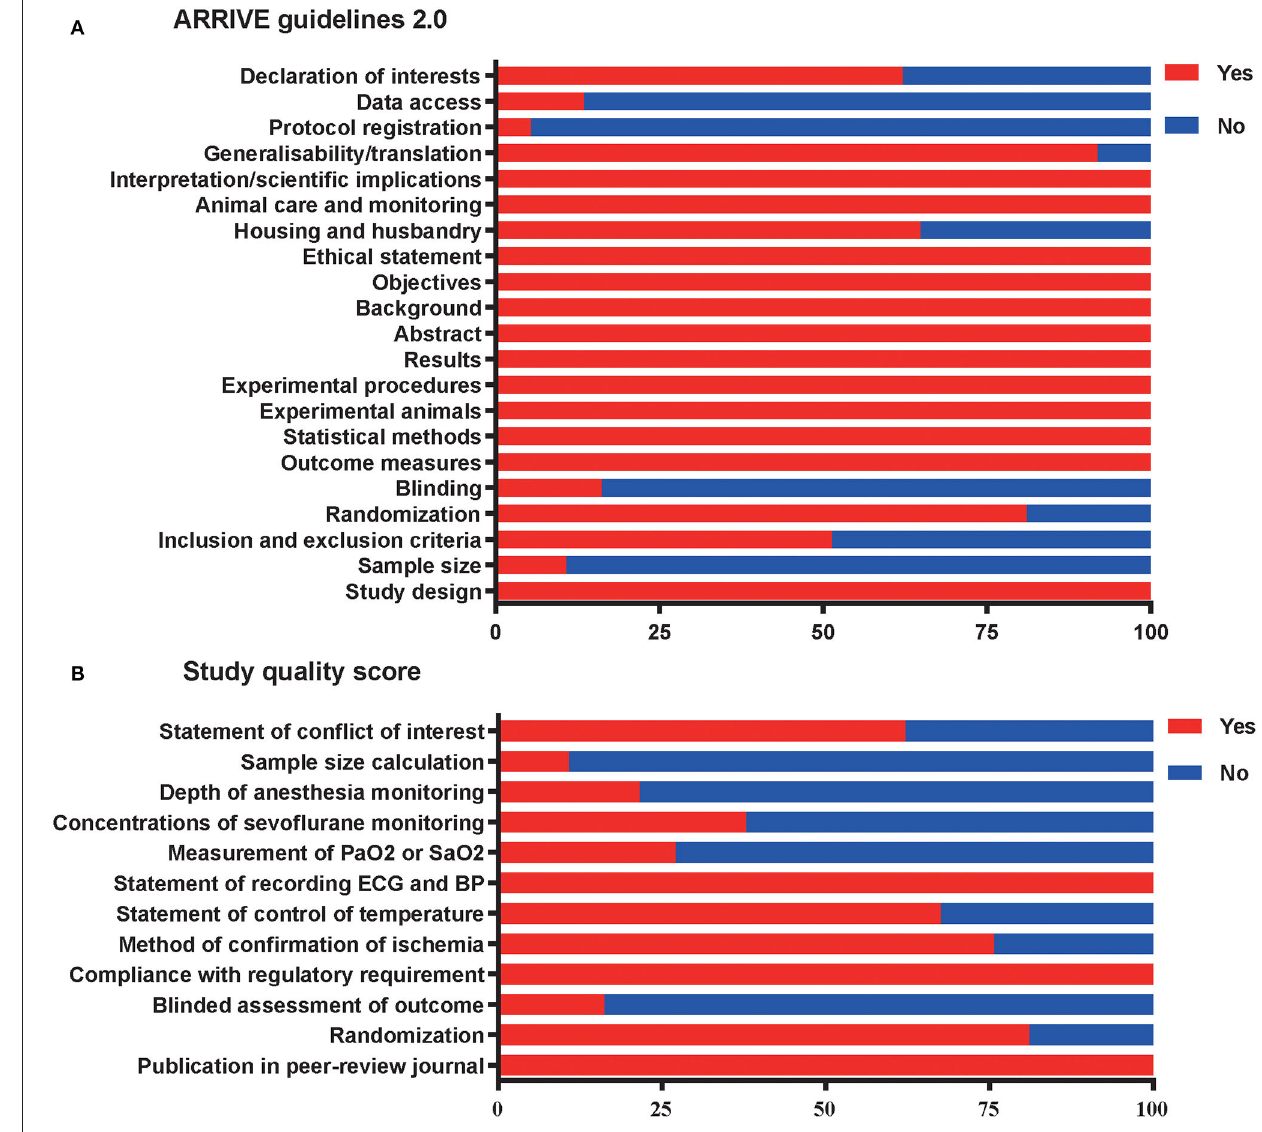
FIGURE 4 | Reporting of study quality indicators. Study quality was assessed using the Animal Research: Reporting of in vivo Experiments (ARRIVE) guidelines 2.0 on reporting (A) and a 12-item quality score (B) . Values are expressed as the percentage of studies reporting each quality